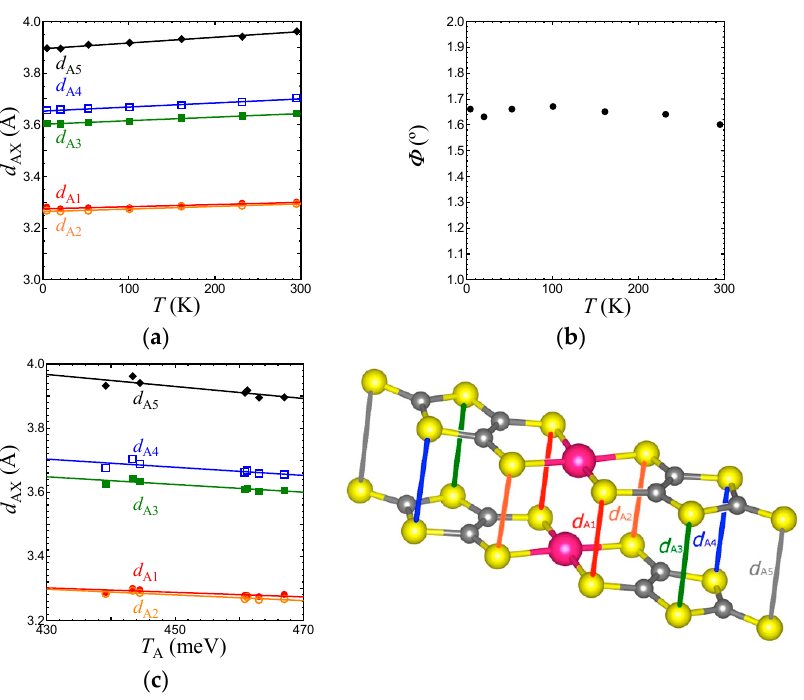
Figure 6. Temperature dependence of ( a ) intradimer S ⋯ S distances, d AX (X = 1–5) and ( b ) Φ , and ( c ) relationship between T A and d AX in the EtMe 3 Sb salt.